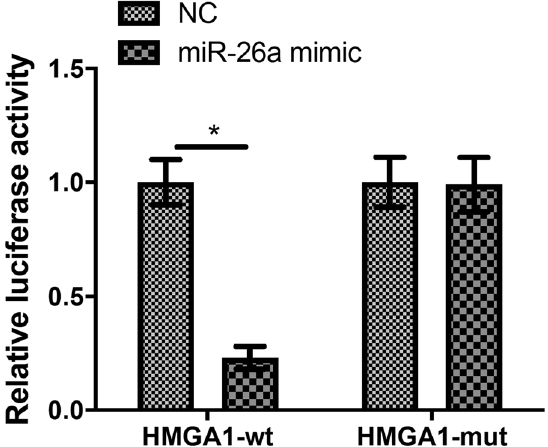
Figure A1: Luciferase assays in ESCC cells co - transfected with wild - type or mutant HMGA1 and miR - 26a or NC. MiR - 26a overexpression signi fi cantly reduced the luciferase activity of the HMGA1 - wt vector.